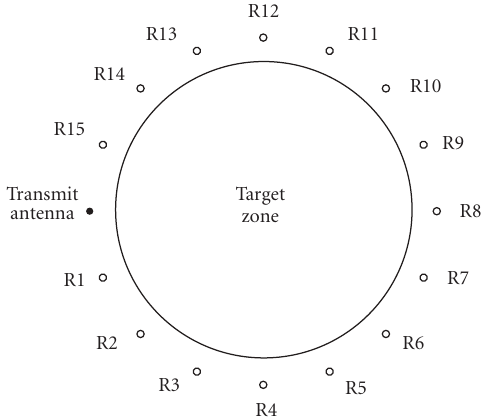
Figure 1: 2D schematic diagram of the 16 monopole antennas ar- ranged in a 15.2 cm diameter circular array surrounding the imag- ing